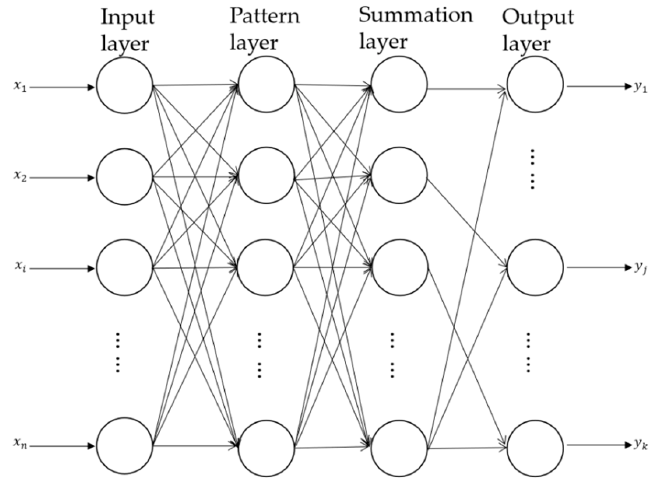
Figure 2. GRNN architecture used for LAI retrieval.